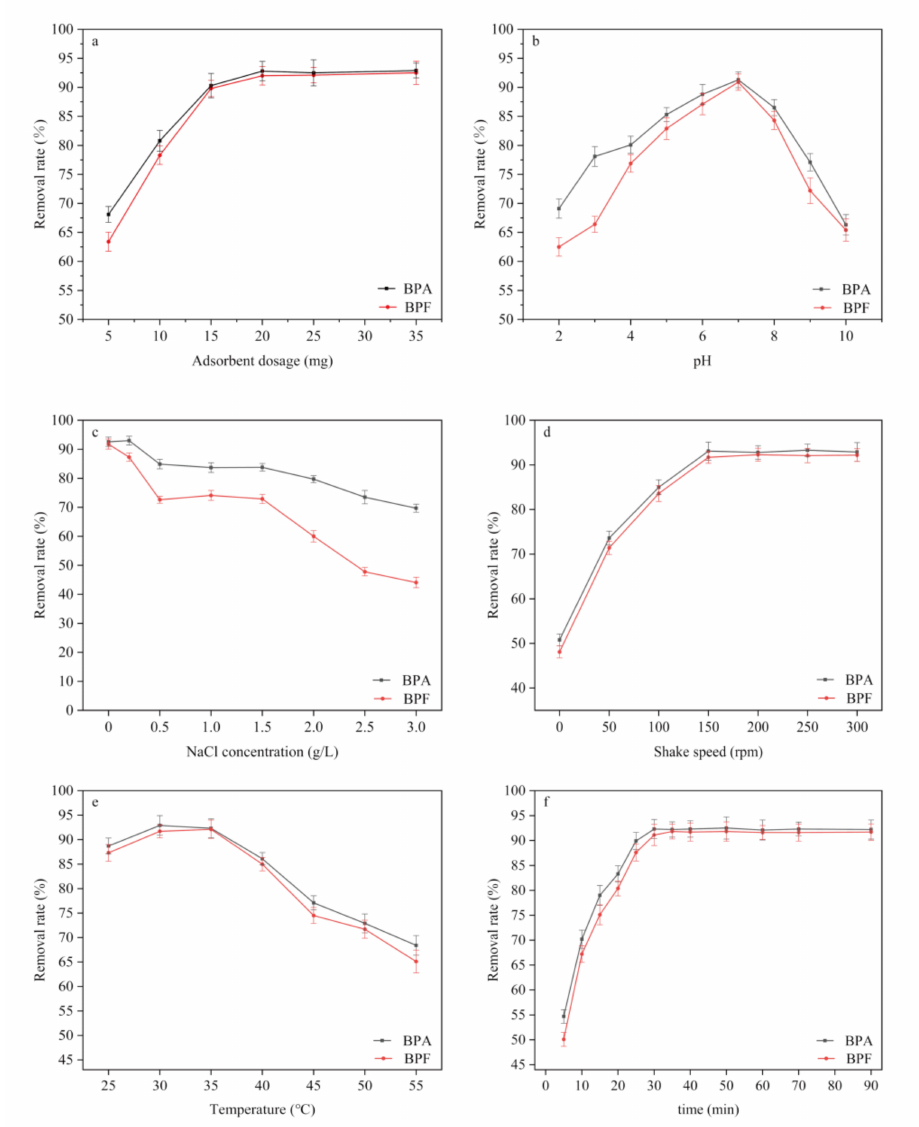
Figure 5. Optimization study for the use of MCGC to remove bisphenol A (BPA) and bisphenol F (BPF): adsorbent dosage ( a ); pH ( b ); ionic strength ( c ); shaking speed ( d ); temperature ( e ); time ( f